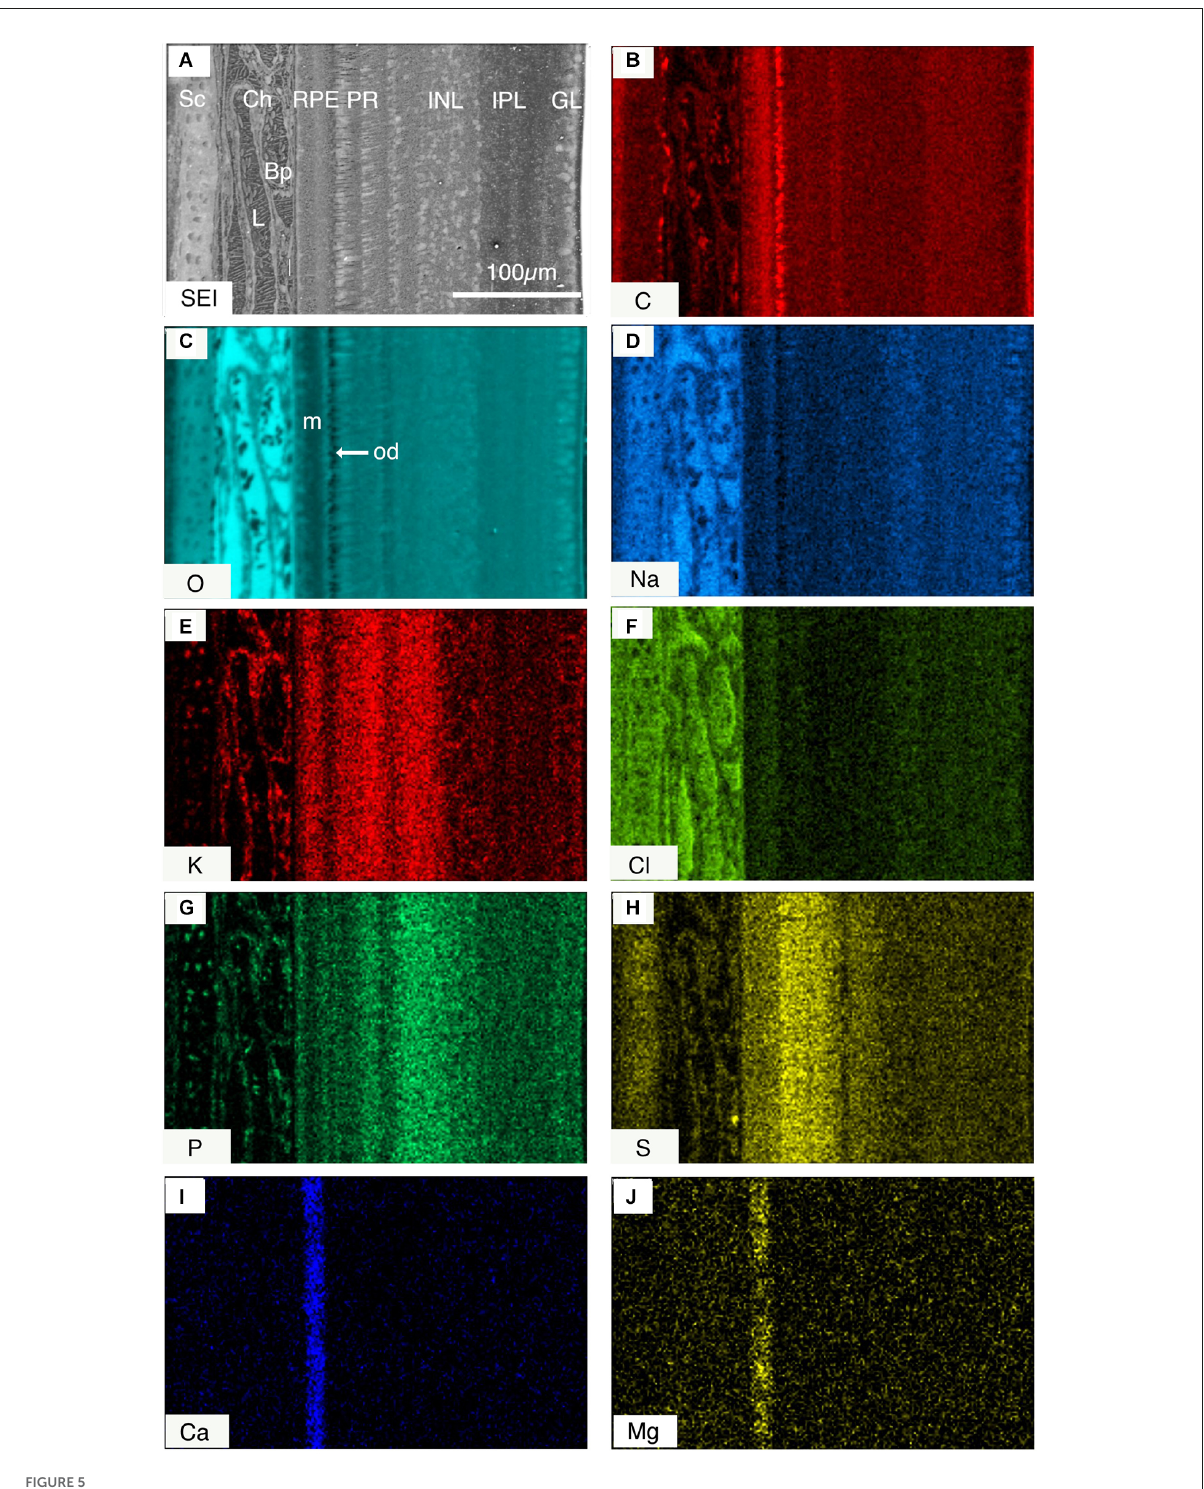
FIGURE5 (A) Secondary electron image (SEI) across the frozen-hydrated retinal complex. (B–H) Qualitative images of the relative distribution of different elements (B) carbon C; (C) oxygen O, (D) sodium Na; (E) potassium K; (F) chlorine Cl; (G) phosphorous P; (H) sulfur S; (I) calcium Ca; and (J) magnesium Mg across the posterior eye, where each color represents x-ray intensity (counts) for a different element. The brighter parts of the images indicate higher concentrations of elements. Note (I) calcium, and (J) magnesium are predominantly localized in the melanosome- containing region of the RPE. Abbreviations: Sc, sclera; Ch, choroid; RPE, retinal pigment epithelium; PR, photoreceptor layer; INL, innernuclear layer; IPL, inner plexiform layer; GCL, ganglion cell layer; m, melanosome-containing region of RPE; od, oil